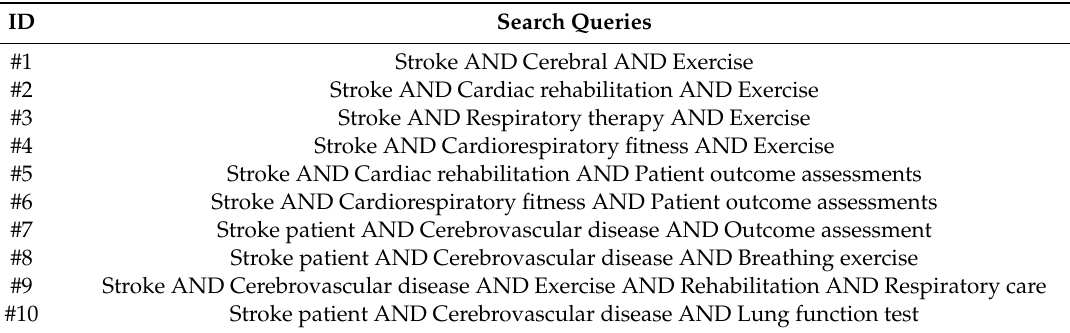
Table 4. Search strategy in the Cochrane